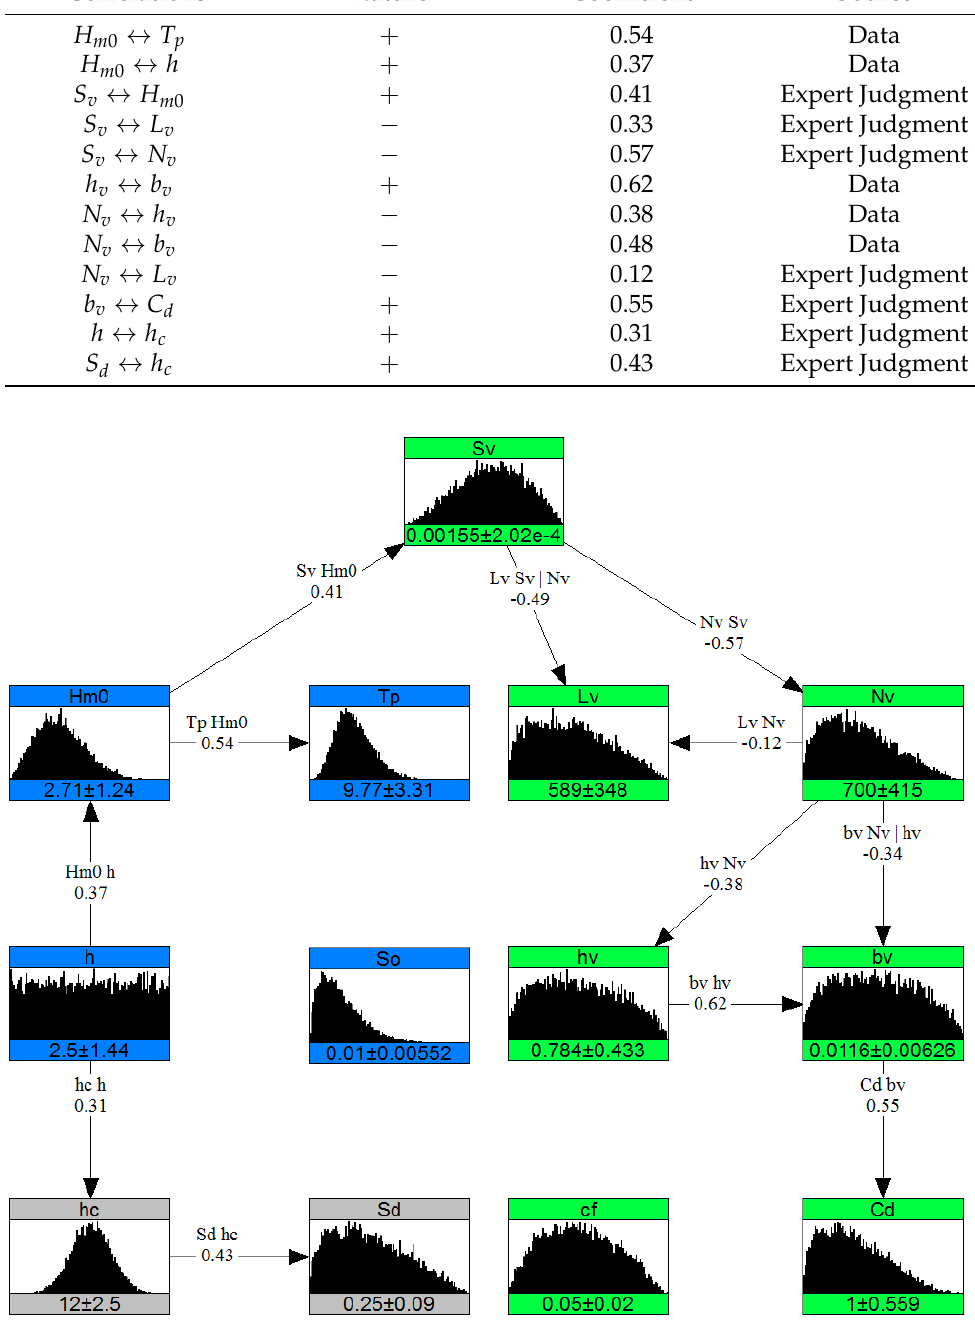
Figure 8. Nonparametric Bayesian network for salt marsh environment [1,30]. The boxes represent nodes (variables with their marginal distributions) and lines represent influences (rank correlations). Color indicates different components in the system: blue for hydrodynamics, gray for dike, light green for seagrass-saltmarsh